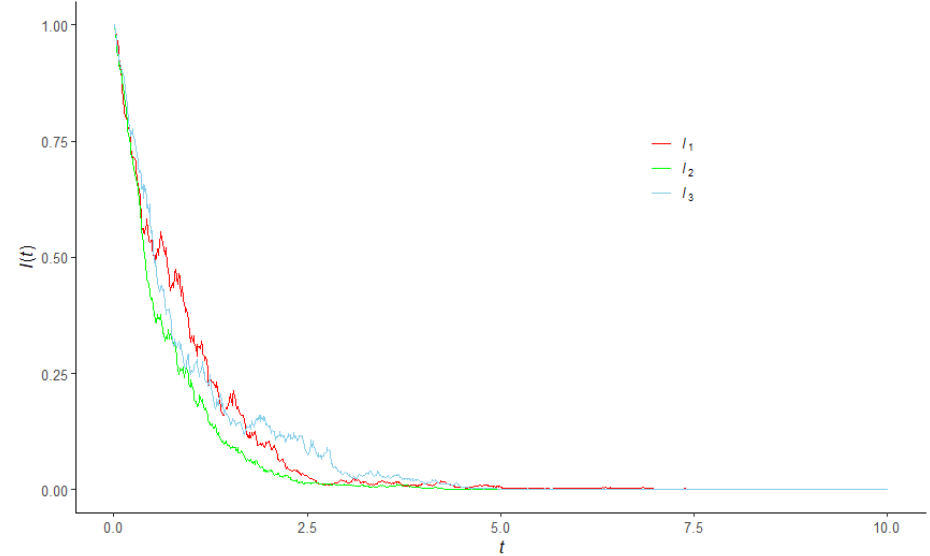
Figure 4. The simulated numbers of infected individuals under condition (b) of Theorem 2.